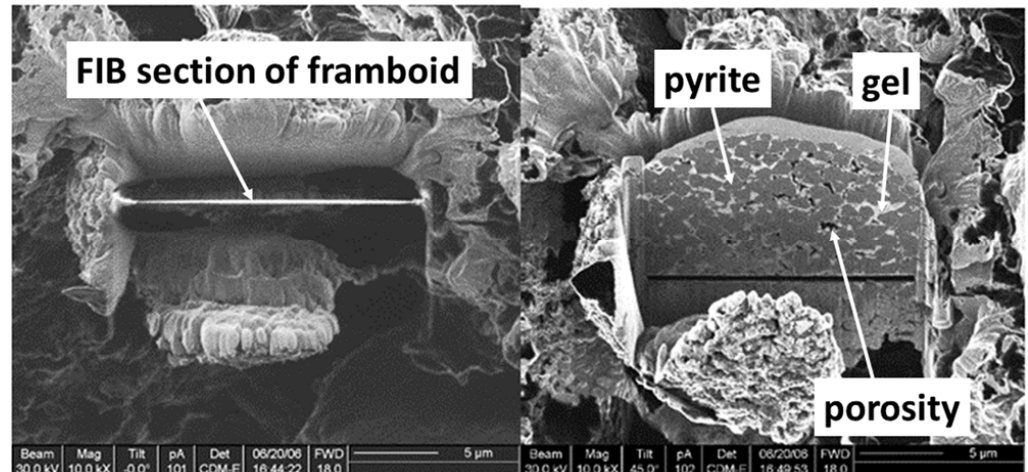
Figure 8. Scanning electron microscopy (SEM) observation of shales from Borehole EST433. Fram- boids of pyrite ( A ) and partially oxidized pyrite ( B ) observed in Toarcian claystones. ( C ) Spherule of former pyrite framboids oxidized observed in Oxfordian claystones and the EDS analysis.